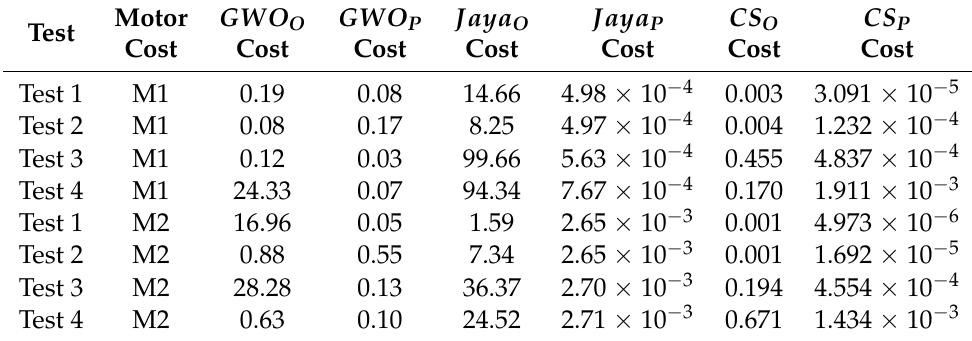
Table 4. Cost/Fitness result for each test in M1 and M2.